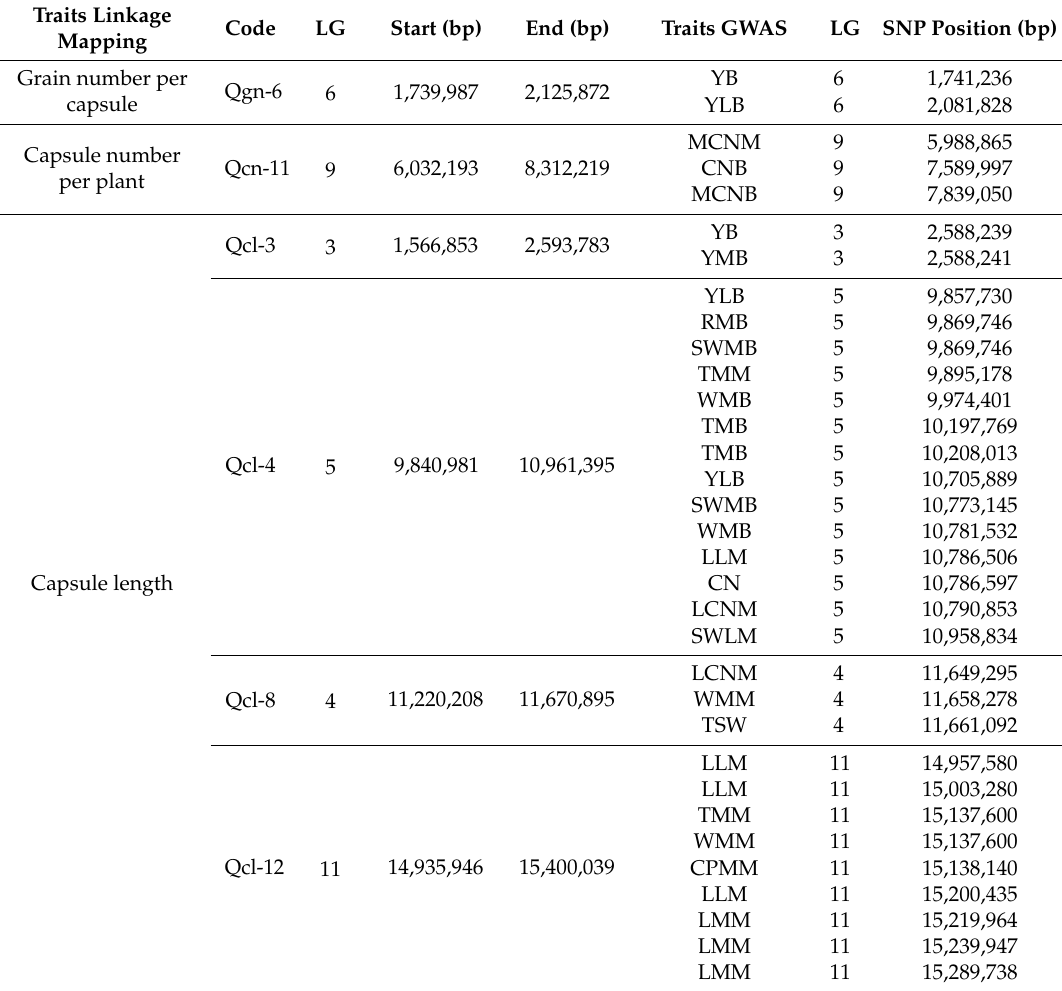
Table 2. Shared genomic regions detected for seed yield-related traits between our GWAS results and previous linkage mapping